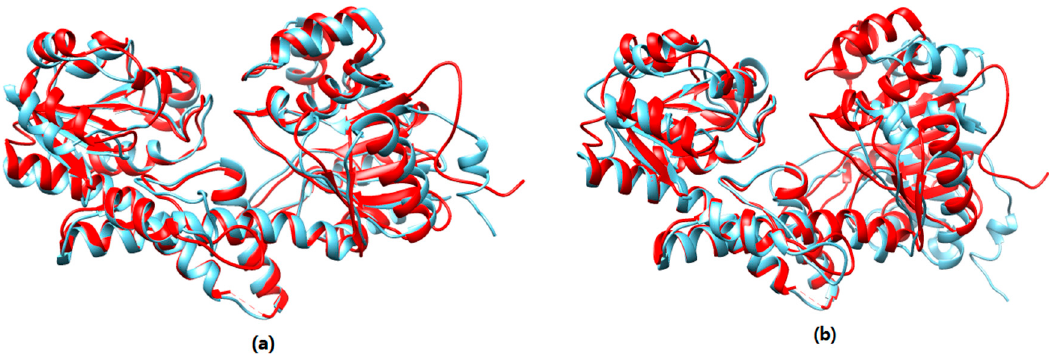
Figure 8. ( a ) The superposition of T0851 native structure and the near-native structure selected by the proposed method. ( b ) The super-position of T0851 native structure and the model selected by SPICKER.